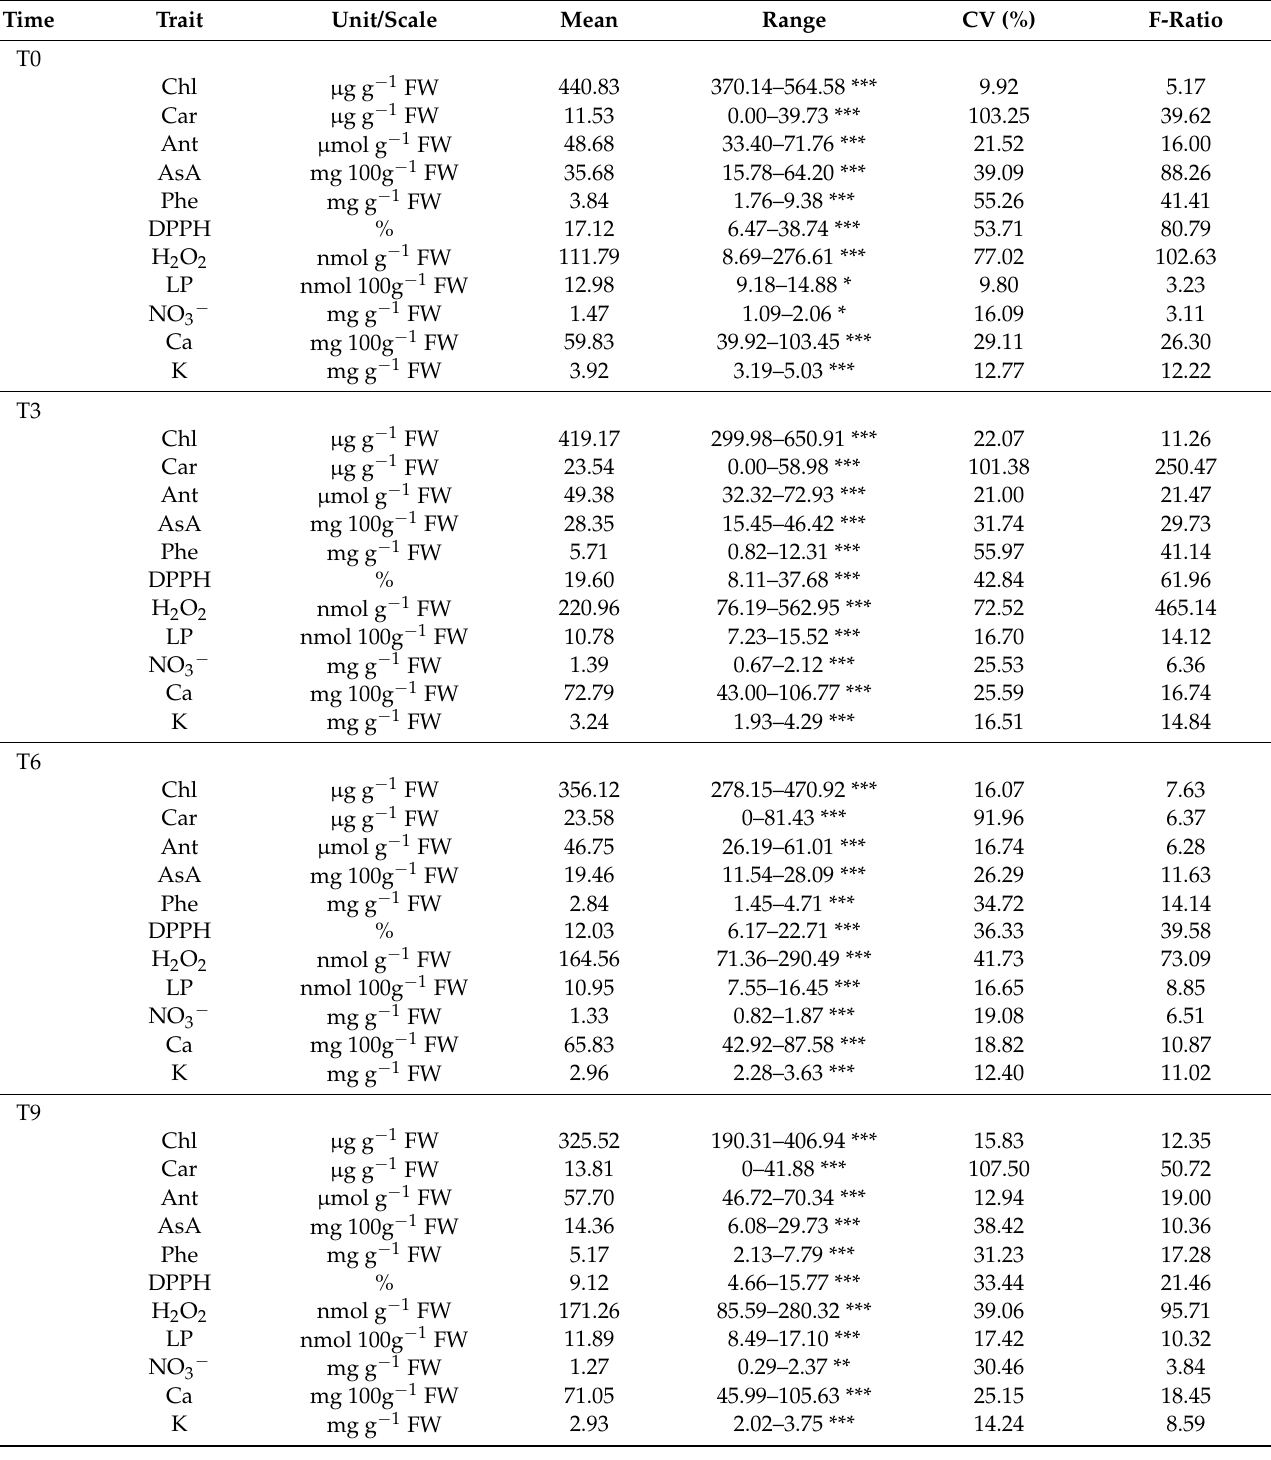
Table 4. Variation parameters for the quality traits in the nine harvested lettuce varieties measured at 0 (T0), 3 (T3), 6 (T6) and 9 (T9) days after conservation under chamber conditions. Statistics were performed per stage. Values represent the mean, range, coefficient of variation (CV, %), F-ratio and significance (***, **, * indicate significance at p < 0.001, p < 0.01, p < 0.05) for quality traits. Chl: Chlorophylls; Car: Carotenoids; Ant: Anthocyanins; AsA: Ascorbic Acid; Phe: Phenols;